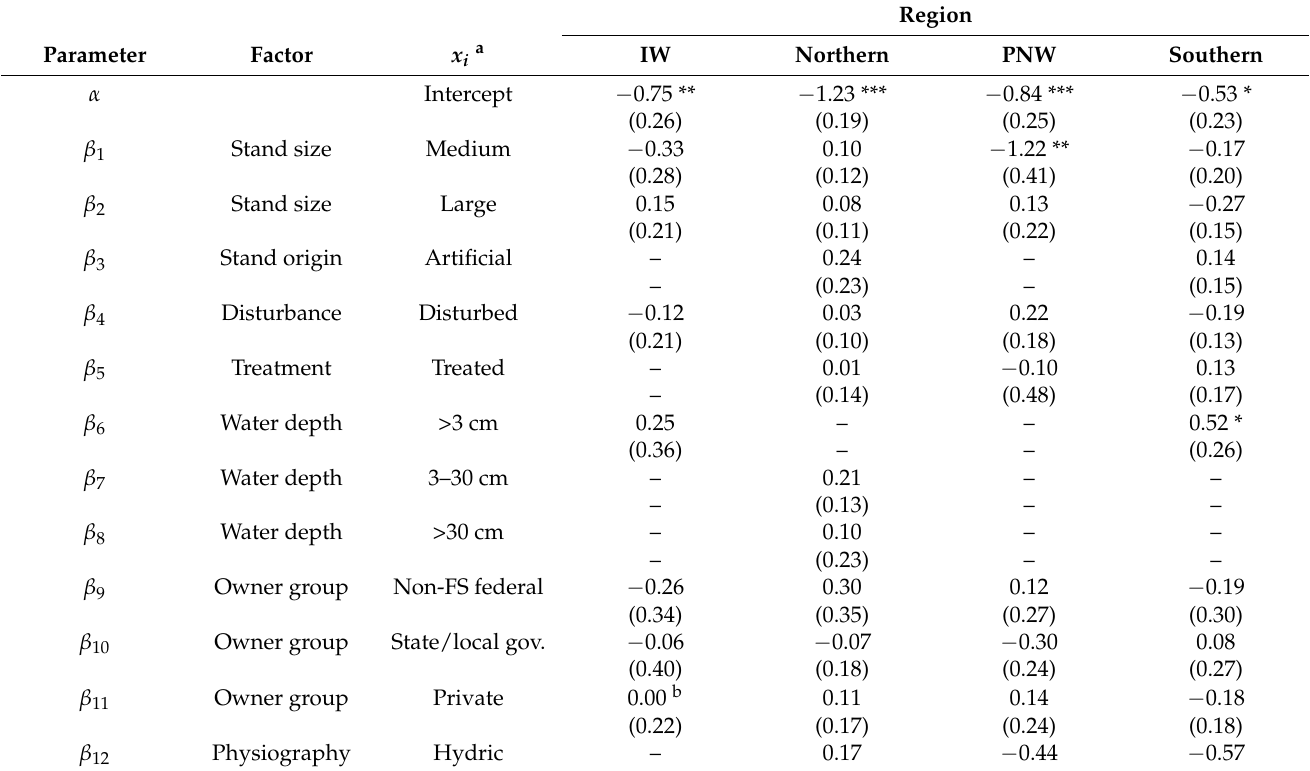
Table 6. Estimated coefficients (and standard errors) for the model logit ( π ) = α + β 1 x 1 + β 2 x 2 + · · · + β 14 x 14 predicting the probability that seedling count is a multiple of four by